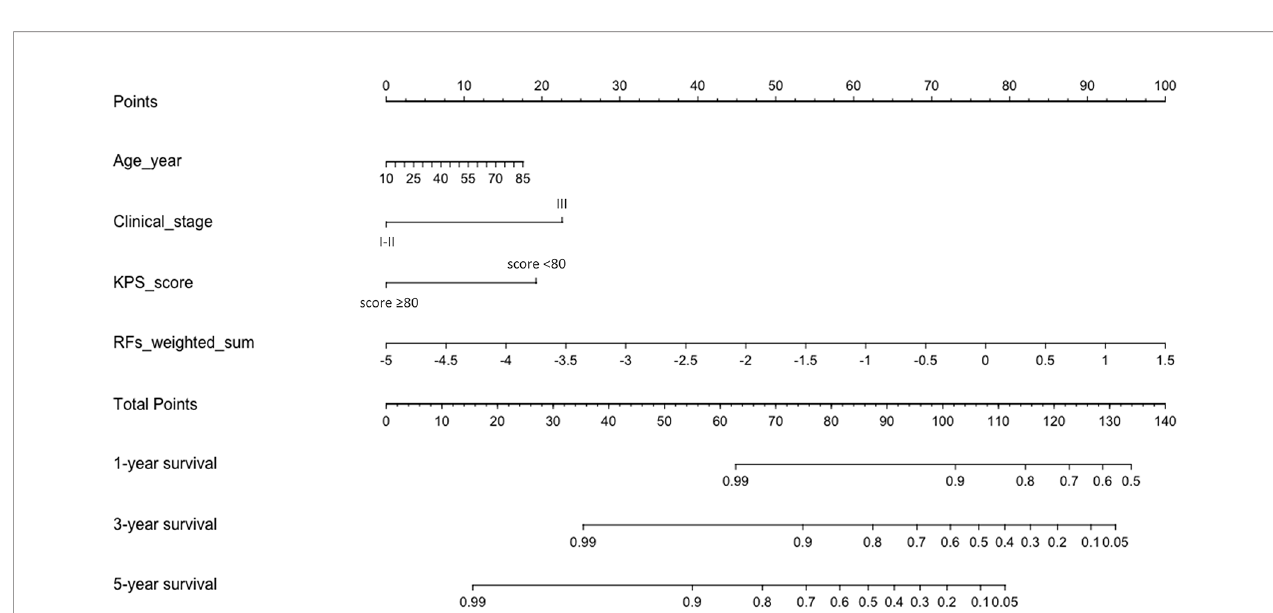
FIGURE 5 | A nomogram for PFS was established that included age, clinical stage, KPS score, and RFs-weighted sum.